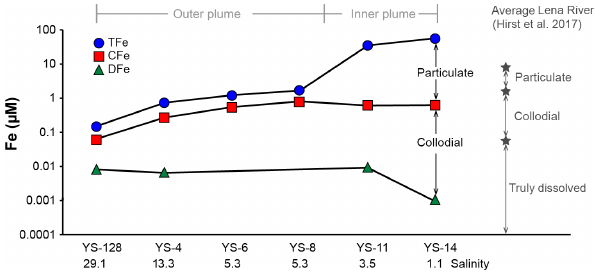
Figure 4. Total, colloidal, and truly dissolved Fe concentrations along the Lena River freshwater plume. Concentrations of PFe and CFe decreased along the salinity gradient, while the concentrations of DFe are almost constant. Note the logarithmic scale and the sharp decrease in PFe between the inner and the outer plume. The refer- ence for the Lena River is an average of all analysed samples (PFe n = 3; CFe and DFe n = 5) by Hirst et al.